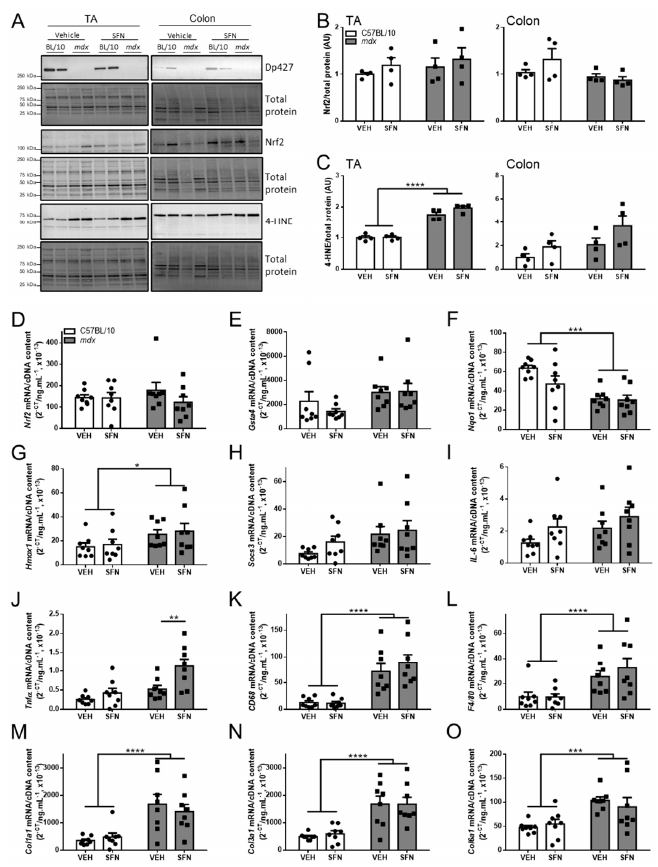
Figure 5. Oral SFN administration does not activate Nrf2 signalling or reduce oxidative stress in limb muscles or the colon. Four-week-old male C57BL/10 and mdx mice received either vehicle (2% DMSO/corn oil; VEH) or SFN (2 mg/kg in 2% DMSO/corn oil; SFN) via daily oral gavage for five days a week for four weeks. Expression of dystrophin Dp427, Nrf2, and 4-HNE ( A ). Levels of Nrf2 protein ( B ) and 4-HNE ( C ) were quantified and expressed relative to levels of total protein. N = 4/group. RNA was extracted from the diaphragm and RT-PCR used to examine gene expression of Nrf2 ( D ), Gsta4 ( E ), Nqo1 ( F ), Hmox1 ( G ), Socs3 ( H ), IL-6 ( I ), Tnf- α ( J ), CD68 ( K ), F4/80 ( L ), Col1a1 ( M ), Col3a1 ( N ), and Col6a1 ( O ). n = 8/group. Statistical analysis was performed using a two-way ANOVA with a Bonferroni’s post-hoc test to assess effects of treatment. * p < 0.05, ** p < 0.01, *** p < 0.001, **** p <